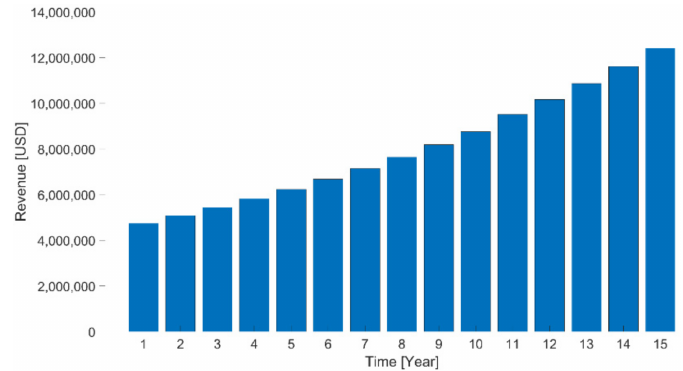
Figure 3. Income statement for the year of Case A.